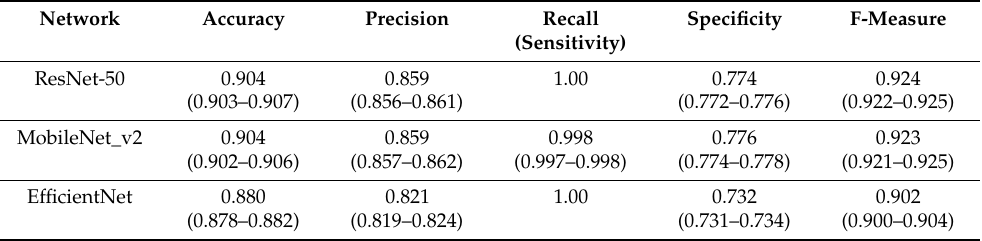
Table 2. Diagnostic accuracy from the learning model was calculated from the confusion matrix created from testing data. The best accuracy score was 0.90 in ResNet-50 and MobileNet_v2; precision was 0.86 in ResNet-50 and MobileNet_v2; recall was 1.0 in all models; and the F-measure was 0.92 in ResNet-50 and MobileNet_v2.